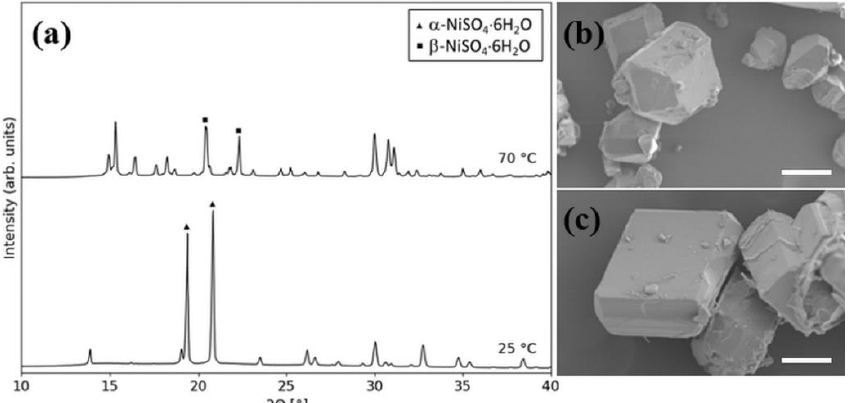
Figure 6. ( a ) XRD spectra of nickel sulfate phases produced at 25 °C and 70 °C, with addition of 2 g seeds and without impurities. ( b , c ) SEM images of crystals precipitated at 25 °C and 70 °C, respectively. Scale bar: 100 µm.